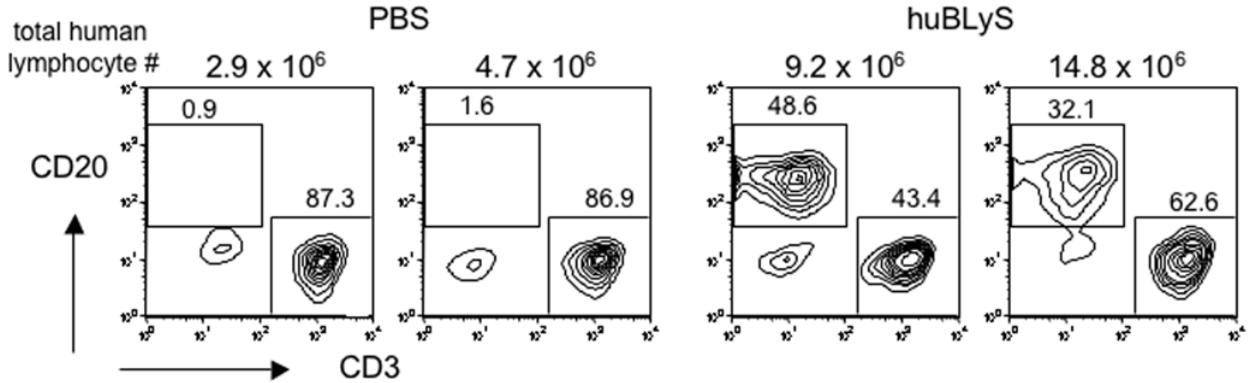
Figure 6. FACS analysis of collagenase disrupted engrafted spleens. One half of engrafted spleens were collagenase digested and then stained with anti-human CD45, CD20 and CD3 antibodies and analyzed by FACS. All samples were gated on live lymphocytes by forward and side scatter and then on CD45 positive cells. Data representative of 3 experiments. Total lymphocyte number=spleen cell count 6 percentage of CD45 + cells.